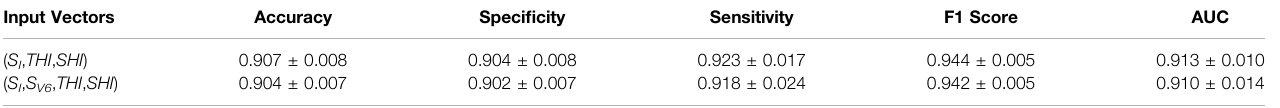
TABLE 6 | Results of feature selection using the grid search for the ECG + VCG model on the training dataset